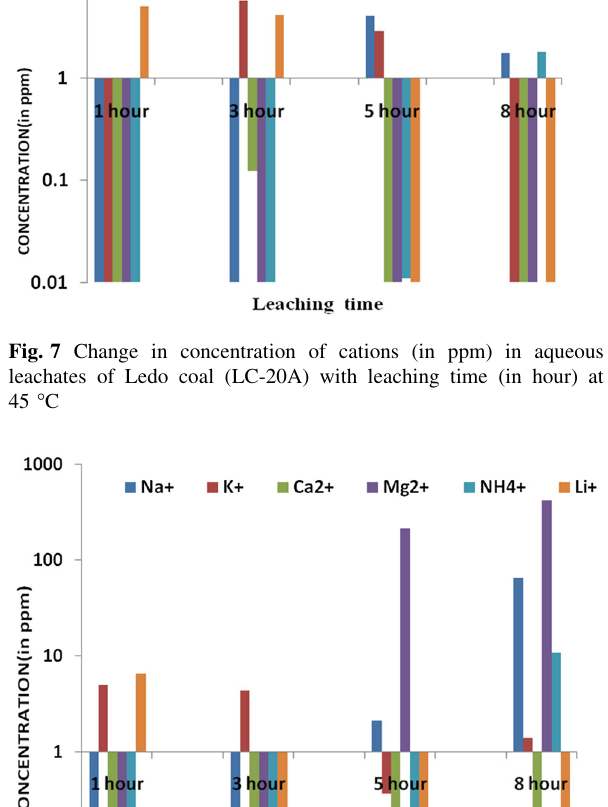
Fig. 11 Change in concentration (in ppm) of anions in aqueous leachates of Ledo coal (LC-20A) with leaching time (in hour) at 25 (cid:3) C